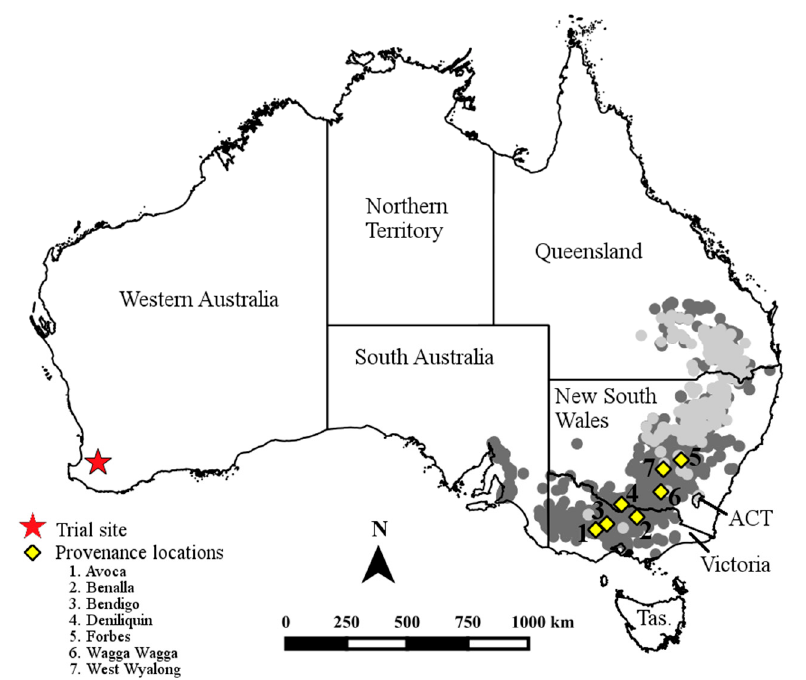
Figure 1. Map of Australia showing original provenance locations and the provenance trial site of Eucalyptus microcarpa (Grey box). Grey dots indicate recorded occurrences of E. microcarpa (dark) and E. woollsiana (light) respectively (data from [41]), providing an indication of the species’ distribution. ACT = Australian Capital Territory. Tas. = Tasmania.